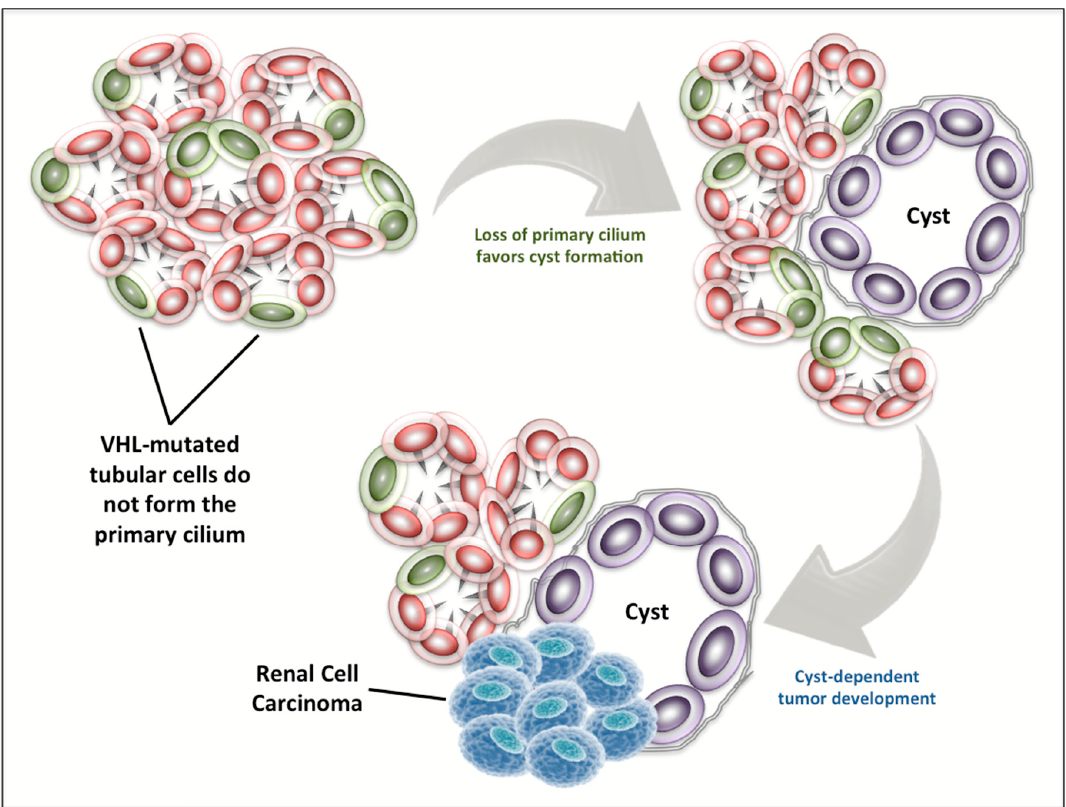
Figure 3. VHL loss in renal carcinogenesis. VHL-mutated tubular cells have been shown to not form the primary cilium. This event favors cyst formation and can lead to the development of renal cell carcinoma.